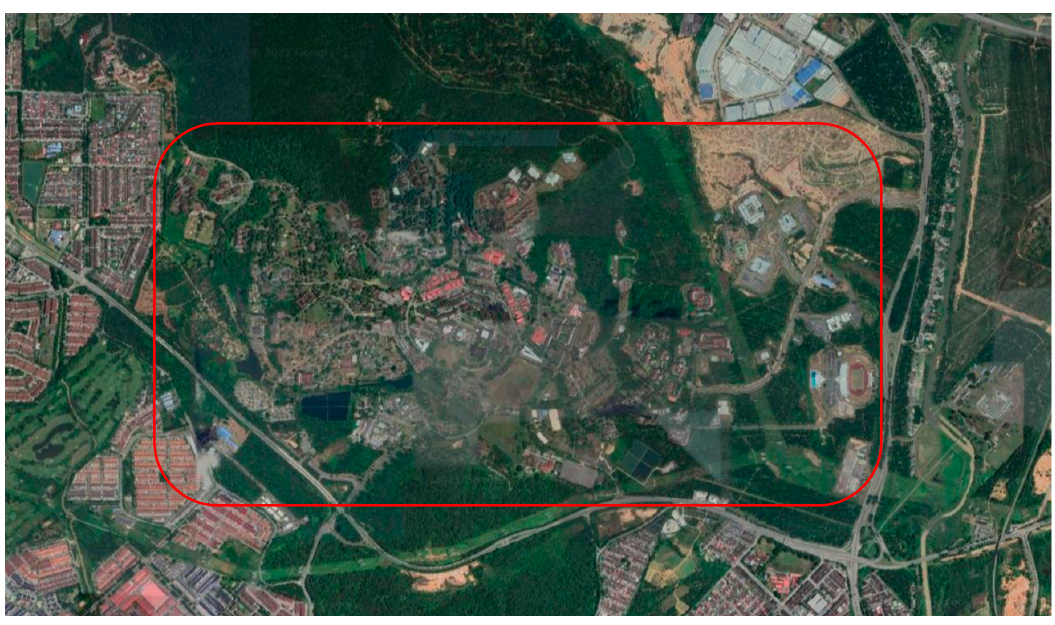
Figure 2. Overview of the study area.